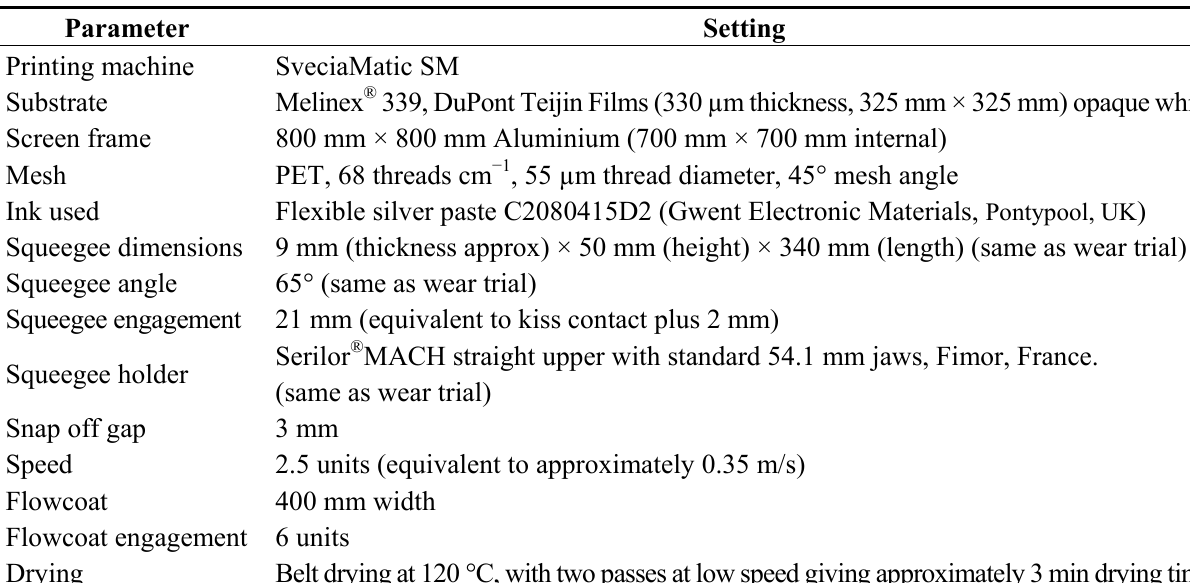
Table 3. Parameters used in printing